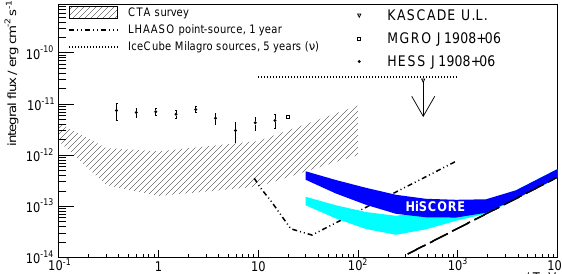
Figure 3: HiSCORE sensitivity as compared to data on MGRO J1908+06 from Milagro (Abdo et al. 2007) and H.E.S.S. (Aharonian et al. 2009), and the sen-